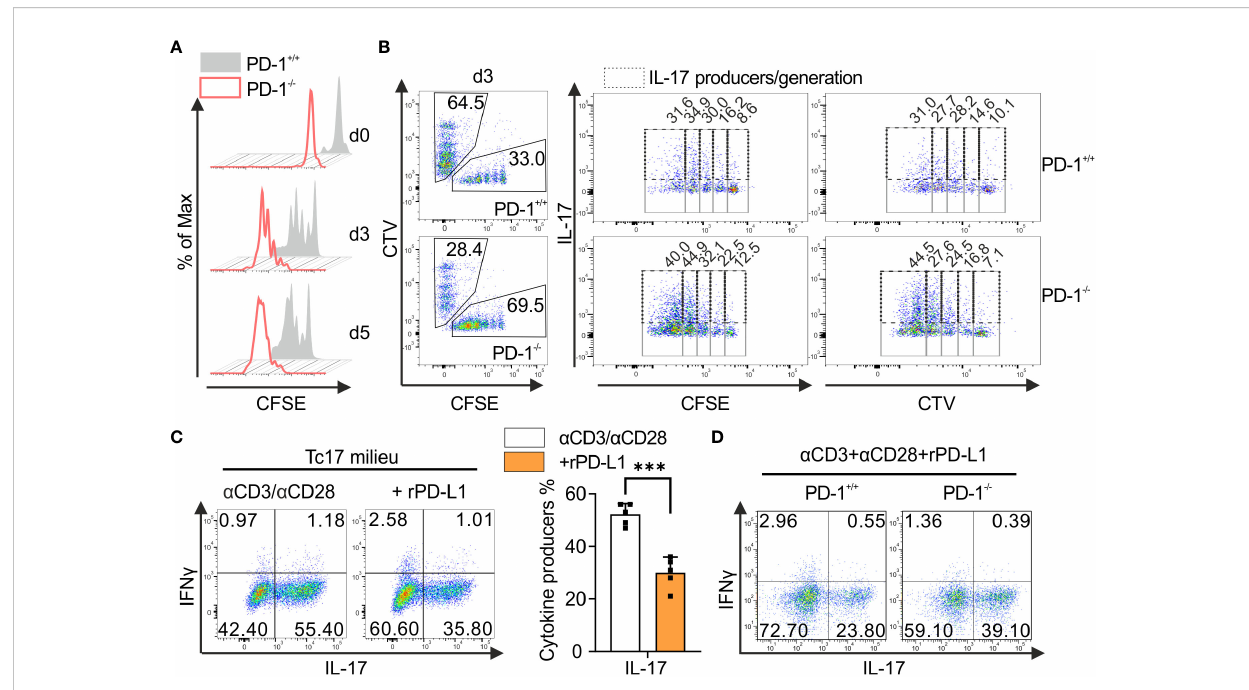
FIGURE 2 PD-1-mediated cell intrinsic signaling regulates Tc17 differentiation. (A) Naïve PD-1 +/+ and PD-1 -/- OT-1 CD8 + T cells were labelled with CFSE (5 m M) before priming them with OVA 257 – 264 loaded APCs and cultured under Tc17 conditions. Proliferation of PD-1 +/+ and PD-1 -/- Tc17 cells was evaluated by CFSE dilution at indicated time points. (B) Naïve PD-1 +/+ and PD-1 -/- OT-1 CD8 + T cells were labelled with CFSE (5 m M) or CTV (2.5 m